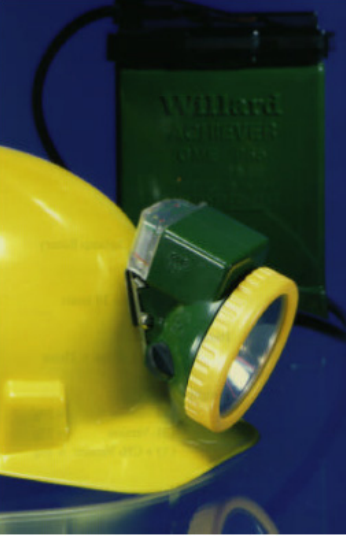
Figure 6. The IYONI II miner’s cap lamp fixed on the helmet.